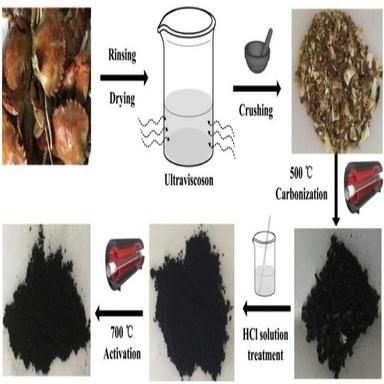
Graphical illustration of the synthesis process of CDC.